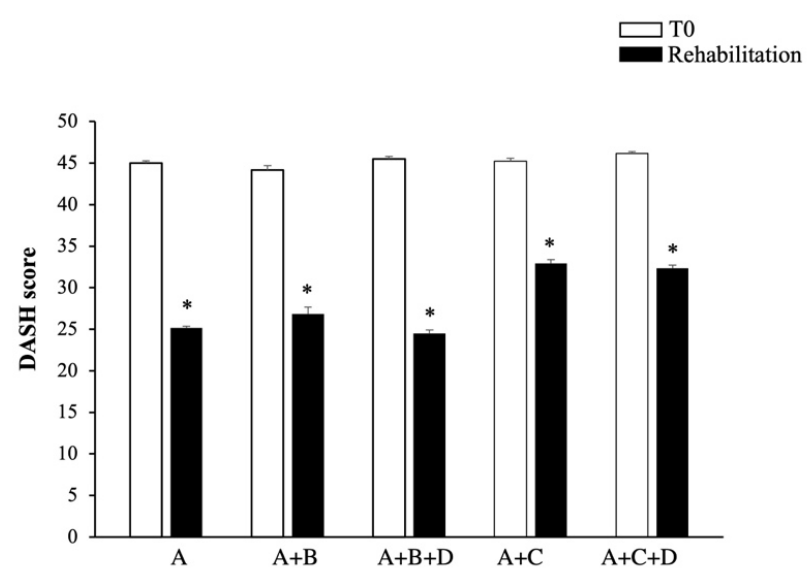
Figure 7. Score distribution of Disability of the Arm, Shoulder, and Hand (DASH) before (T0) and after (T1) the different rehabilitation paths. Higher values indicate greater disability. * p < 0.05 compared with T0.